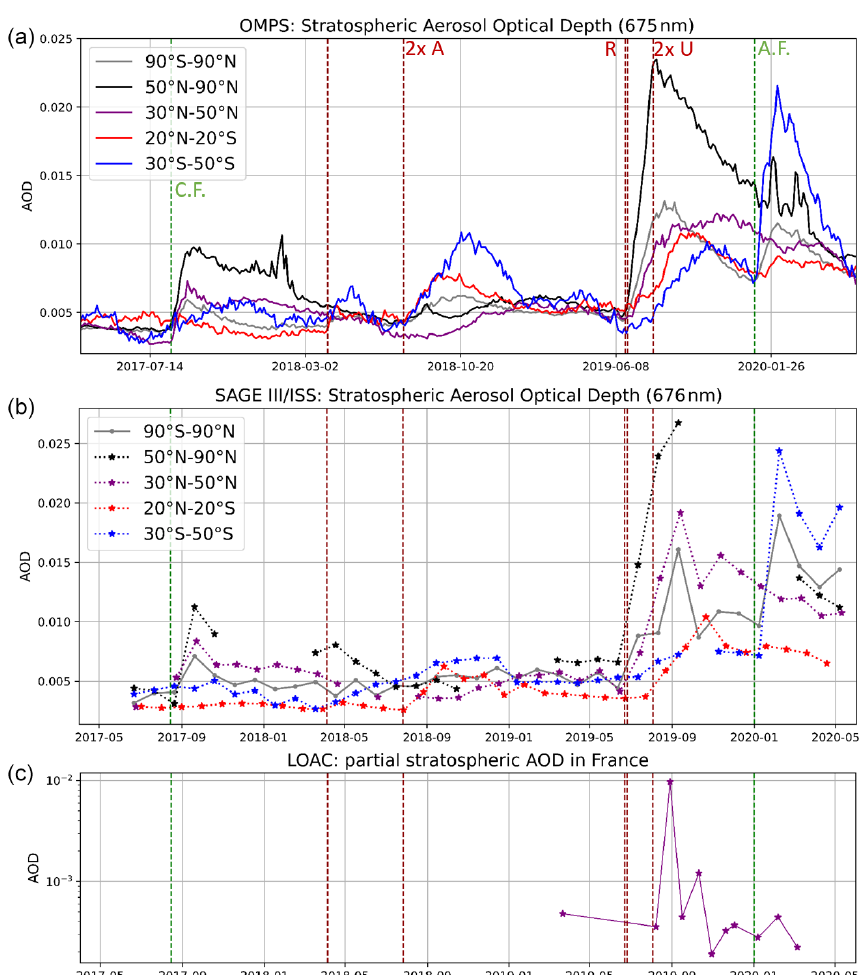
Figure 8. (a) 3d mean sAOD from OMPS aerosol extinction values (from tropopause altitude up to 30km) averaged over five latitude ranges (global, 50–90 ◦ N: north of Raikoke, 30–50 ◦ N: south of Raikoke, 20 ◦ S–20 ◦ N: tropics and 30–50 ◦ S: SH, respectively). Vertical lines represent the event dates of the Canadian fires (C.F.), both Ambae eruptions (2xA), the Raikoke eruption (R), both Ulawun eruptions (2xU) and the Australian fires (A.F.). (b) Same as (a) but with SAGE III/ISS measurements for 30-day averages. The maximum value is an average over the month of September (30 August–29 September 2019) with 221 measurement profiles in a latitude range from 50 to 61 ◦ N (black line in (b) ). The respective averaged AOD for August (31 July–30 August 2019) considers 51 profiles from 50 to 58 ◦ N. (c) Derived partial sAODs for balloon-borne LOAC aerosol concentration observations from Ury in France, for particle sizes from 0.2 to 0.7µm from the tropopause up to 23km